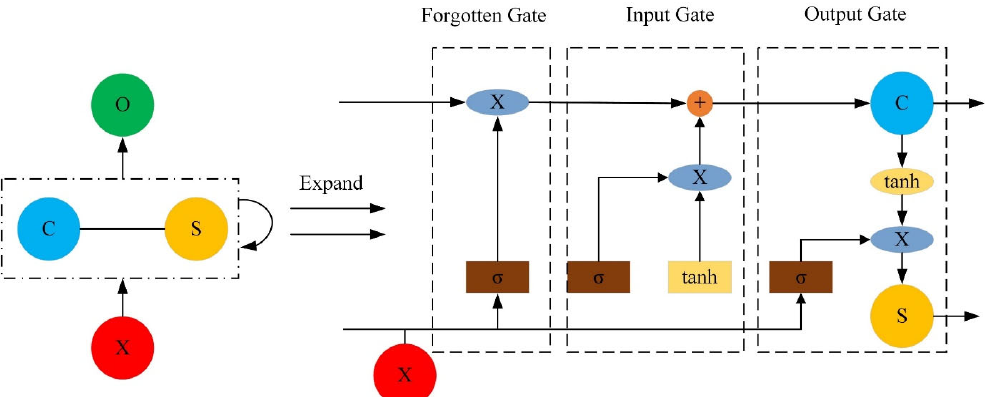
Figure 5. LSTM network design structure. It introduces the cell state C to store the long-term information of the sequence, and S is the output of the current storage cell. σ represents the sigmoid activation function, while × and + represent the matrix multiplication and addition, respectively.